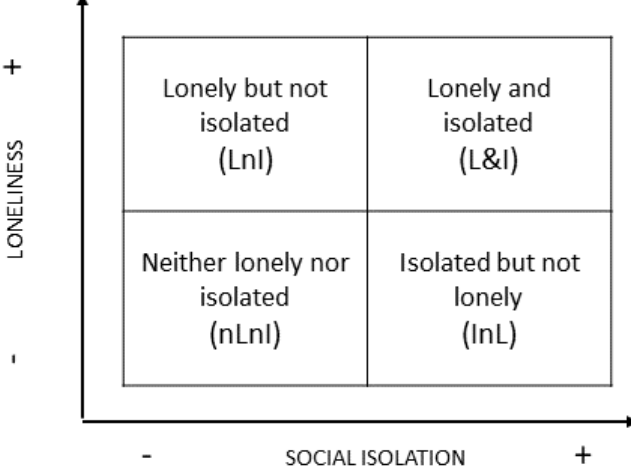
Figure 1. Combination of Social Isolation and Loneliness: Four-Group Typology.